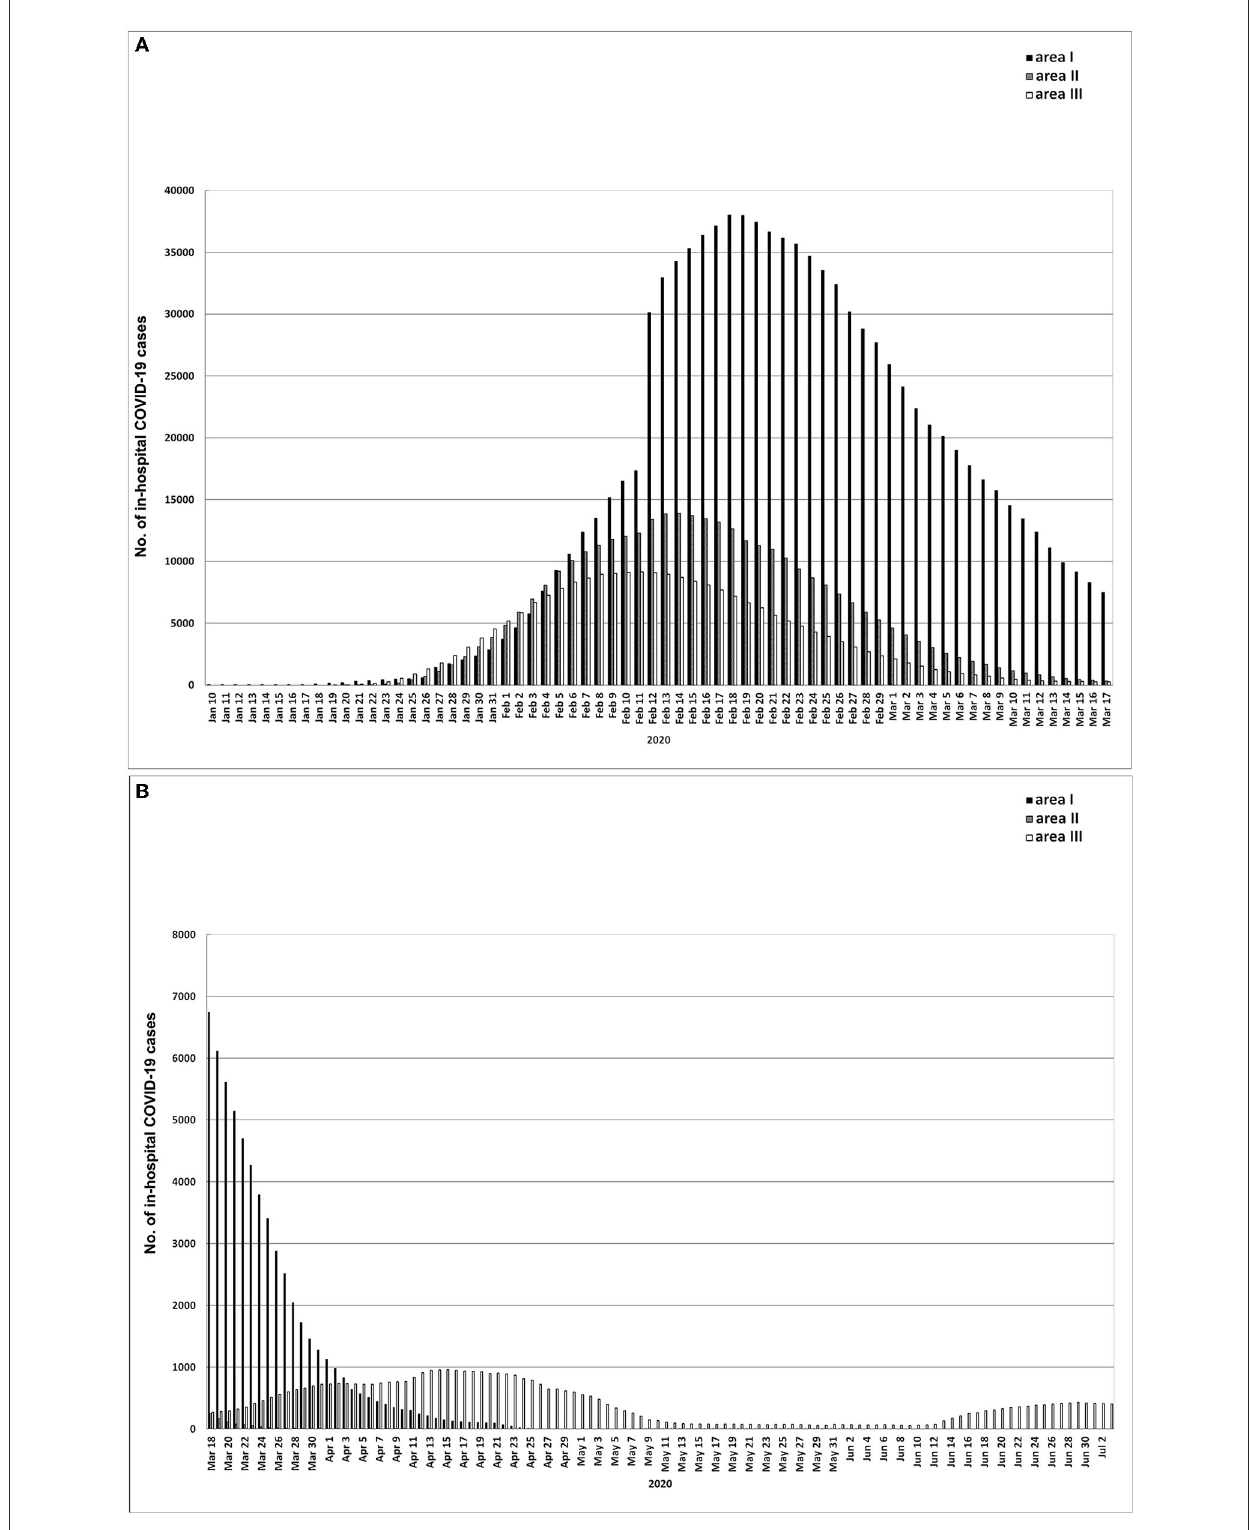
FIGURE4 (A, B) In-hospital COVID-19 cases updated daily in areas I, II, and III. Area I, Wuhan city. Area II, Hubei province (excluding Wuhan city). Area III, Chinese mainland (excluding Hubei